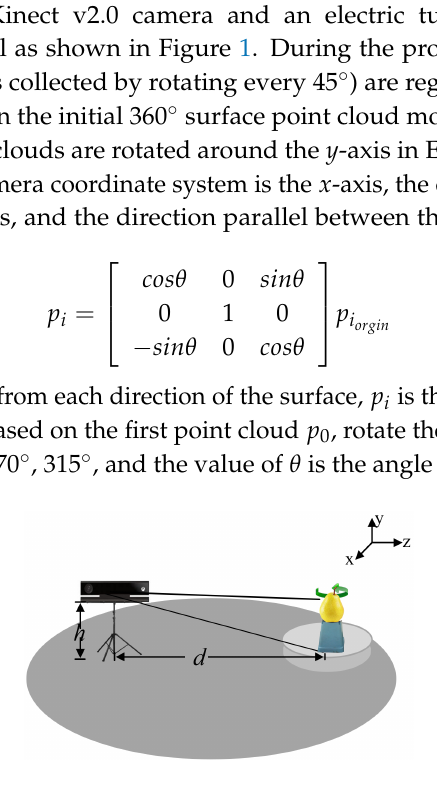
Figure 1. Point cloud acquisition with the Kinect and turntable in the